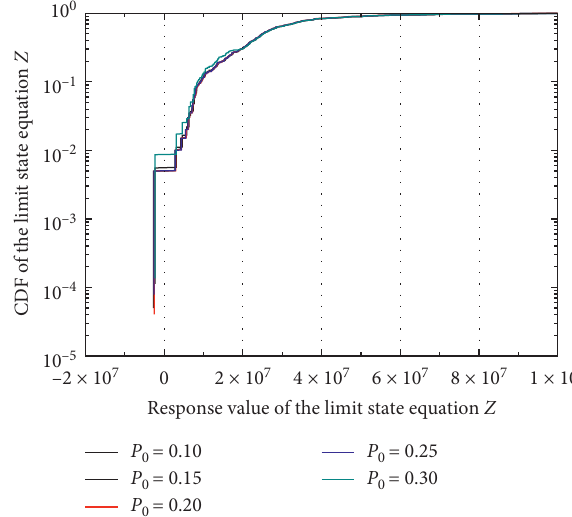
Figure 8: Comparison of probability and statistics characteristics of FPS.